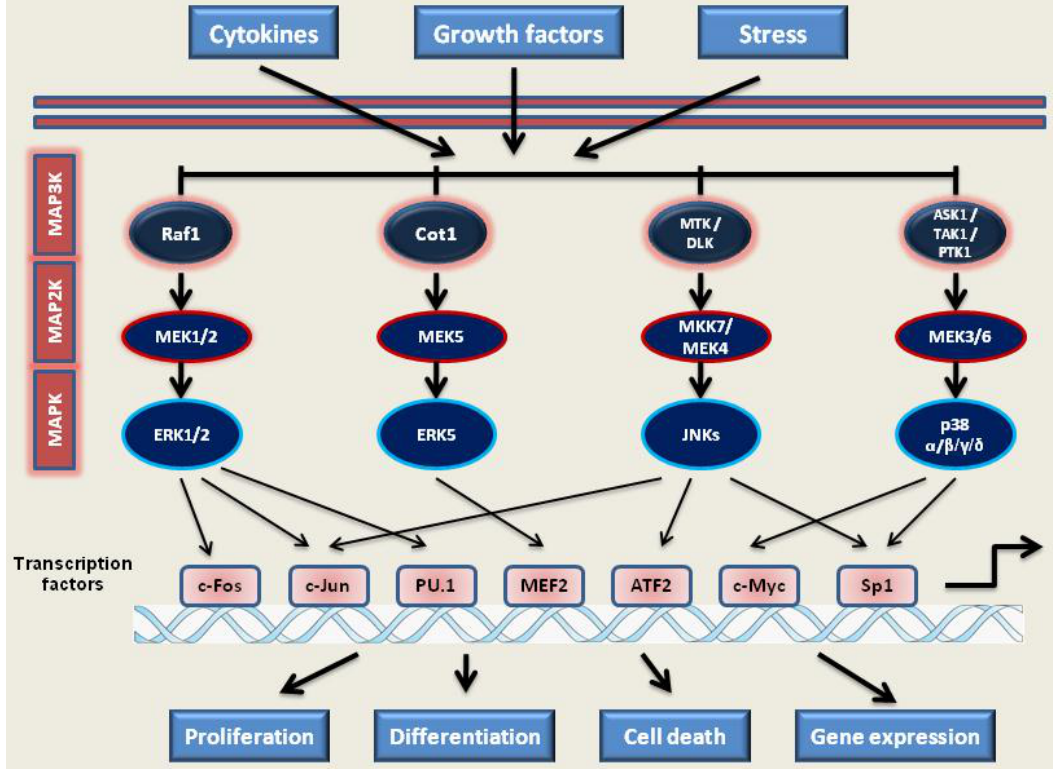
Figure 1. MAPK signaling